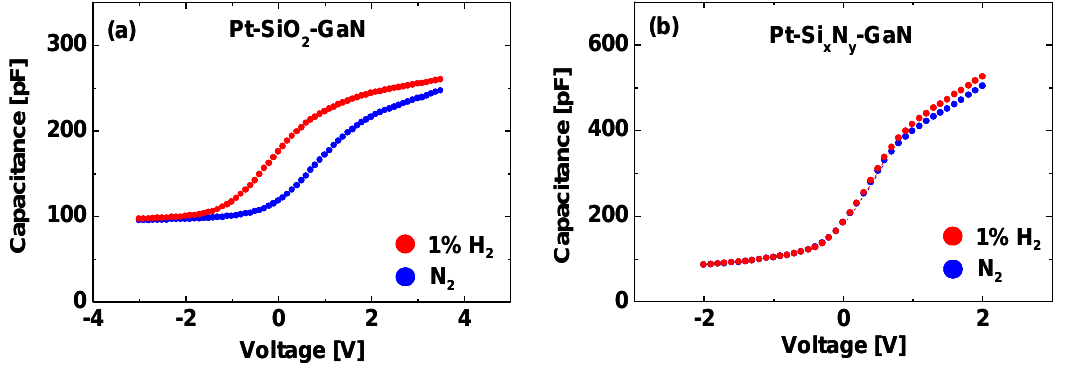
Figure 8. Room-temperature C-V characteristics at 10 kHz of the MIS Pt–GaN diodes with both SiO (a) and Si N (b) dielectrics in a N 2 x y exposure to 1% H in N . Reproduced with permission from Reference [22]. 2 2